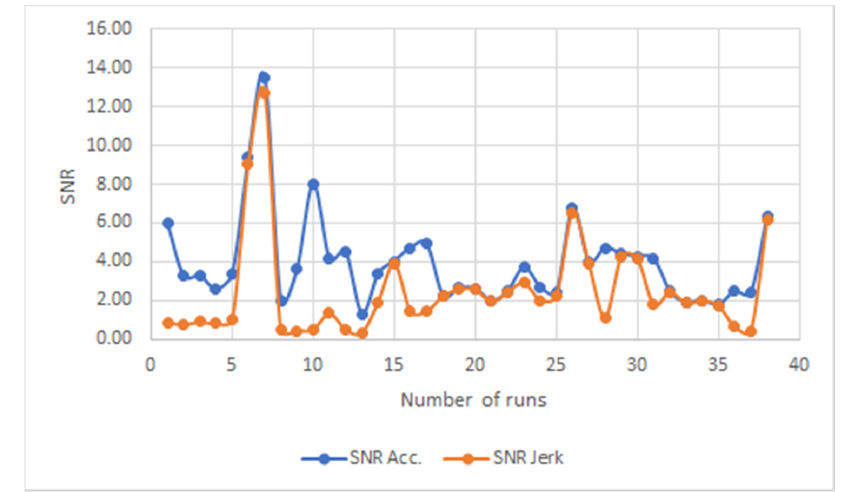
Figure 4. SNR for novice users.